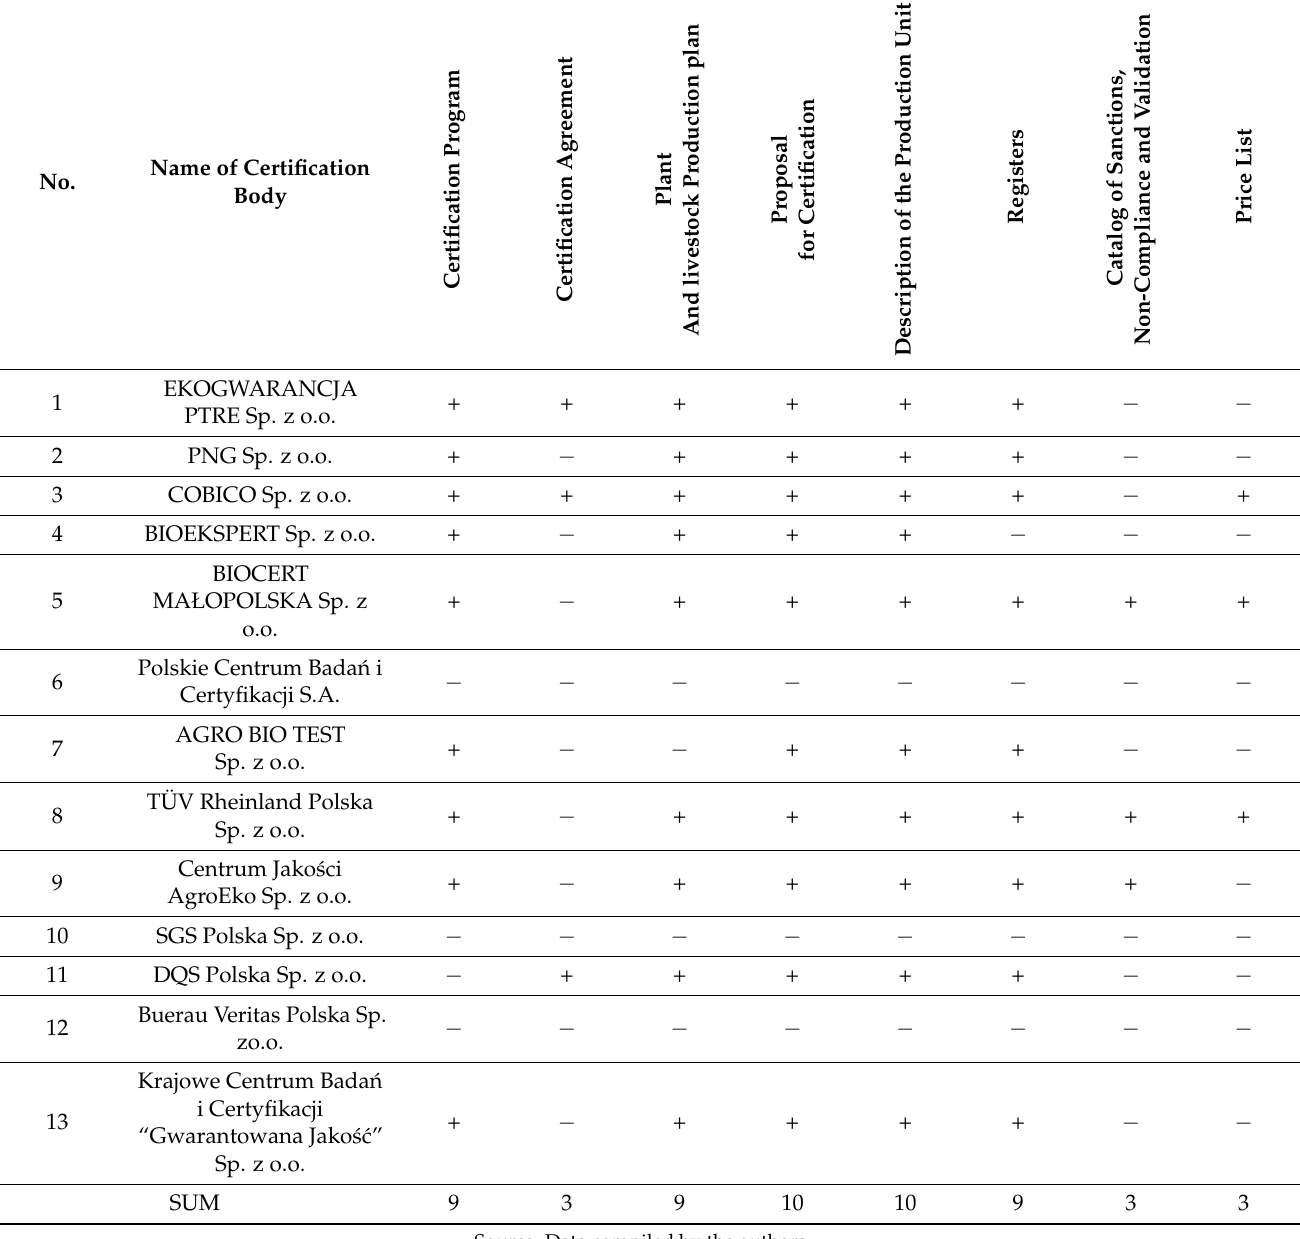
Table 1. Documents and forms provided by organic farming certification bodies on their official websites.